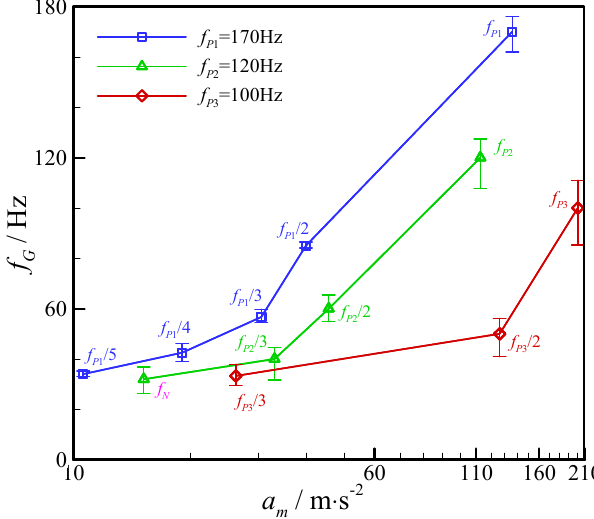
Figure 7. Variation of droplet generation frequency with external vibration amplitude in the flow-focusing microfluidic device. ( Q c = 60 µ L / h and Q d = 60 µ L / h.).